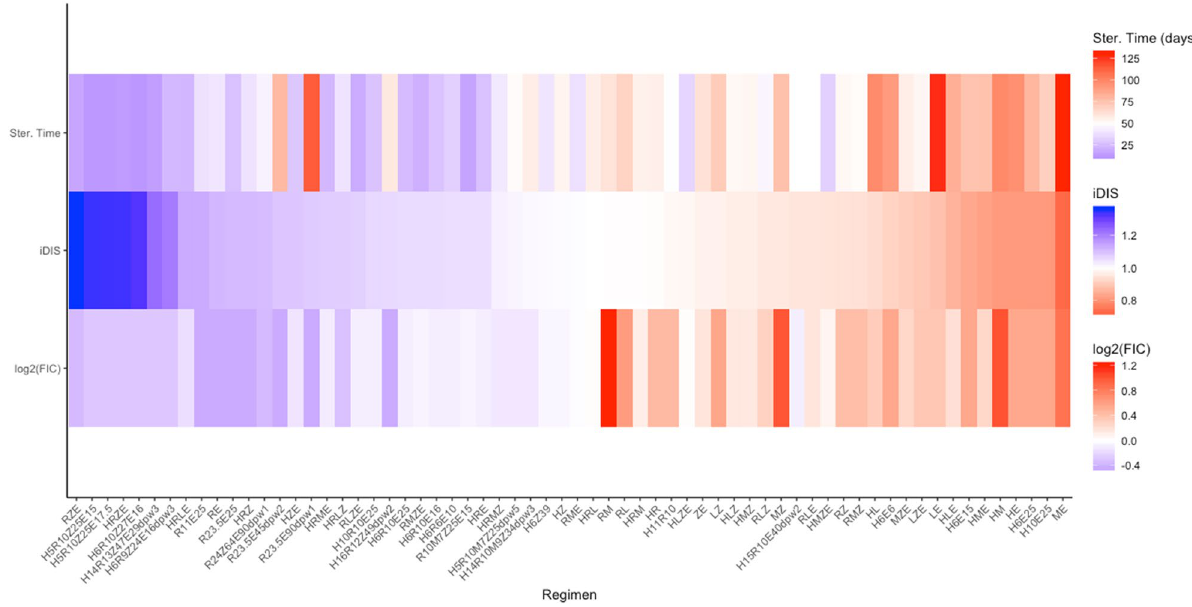
Figure 4. Heat map capturing three metrics for 64 different regimens. The list of regimens is ordered by decreasing predicted iDIS (middle row). For each regimen, the log 2 (FIC) value (bottom row) and the average predicted granuloma sterilization time (top row) are also represented. For predicted iDIS and FIC, blue represents synergy, white represents additivity, and red represents antagonism. For sterilization time, blue represents shorter sterilization times and red represents longer. Heat maps were made using the ggplot2 package in R 39